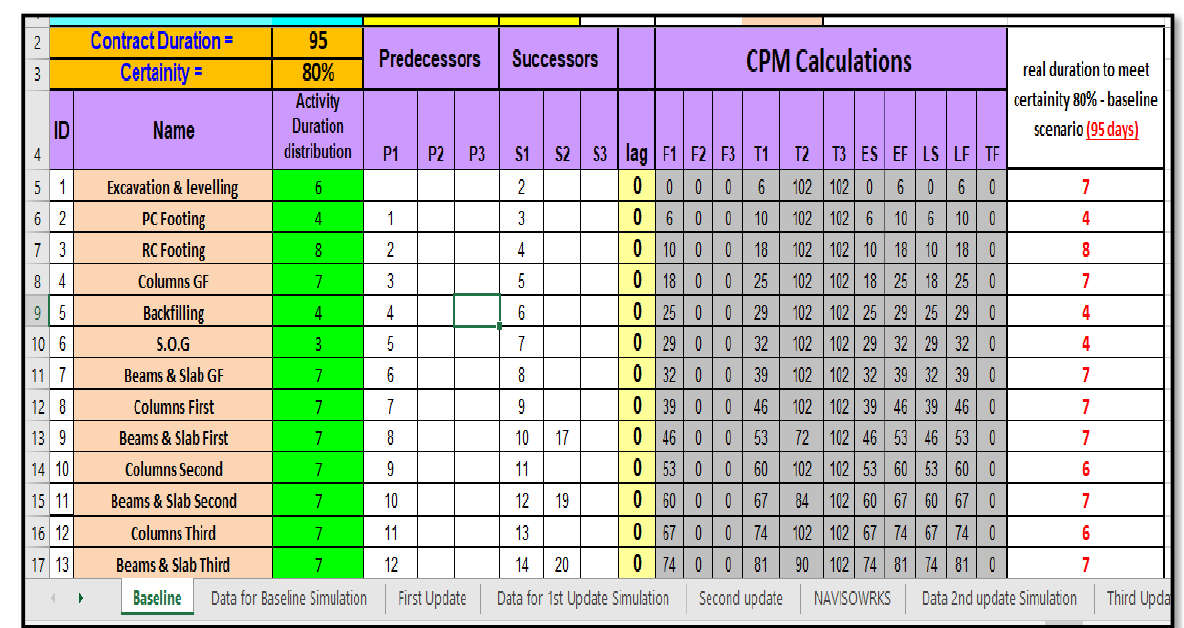
Figure 4. The interface of the spreadsheet model.